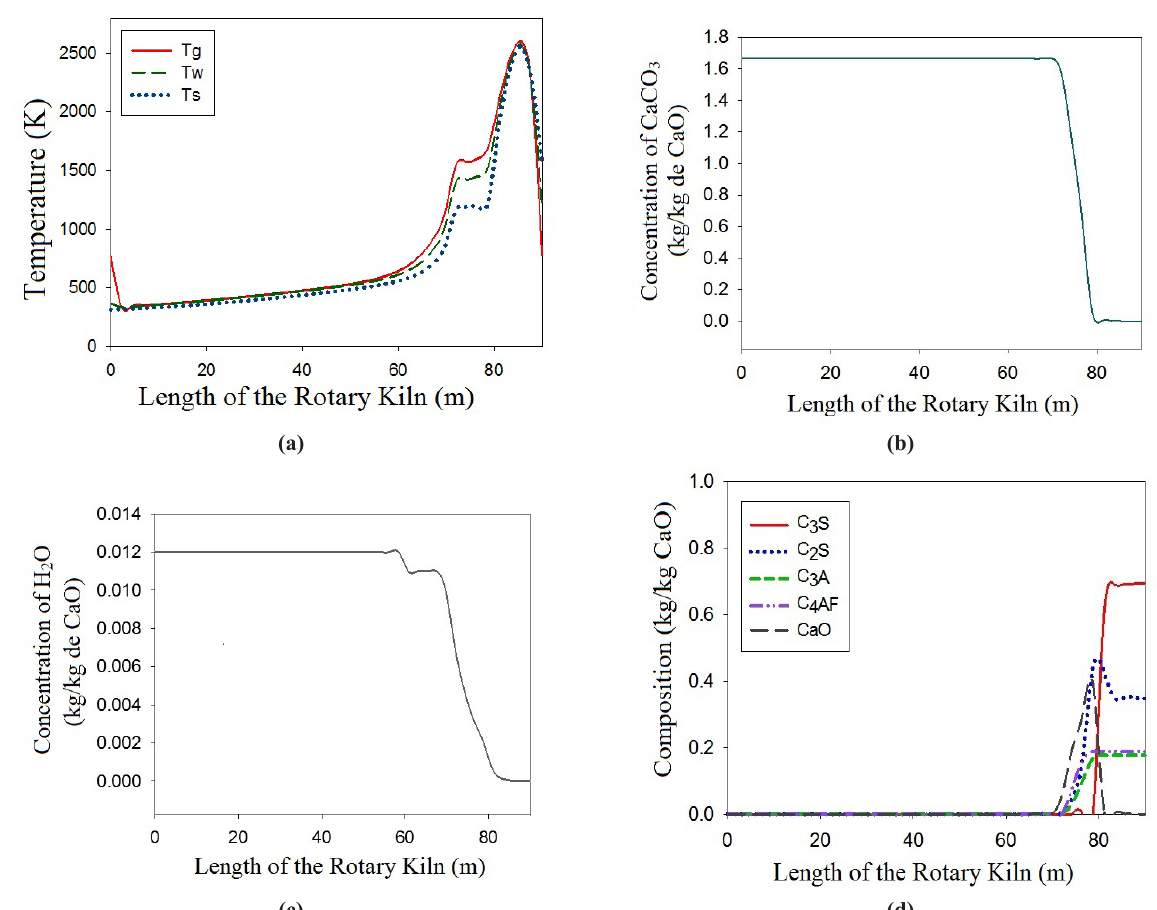
Figure 2 - Temperature profiles of the gas, the solid and the industrial rotary kiln’s wall ( a ); concentration profiles of CaCO3 ( b ); concentration profiles of water ( c ) and concentration profiles of C3S, C2S, C3AF and CaO ( d ) in the industrial rotary kiln at steady